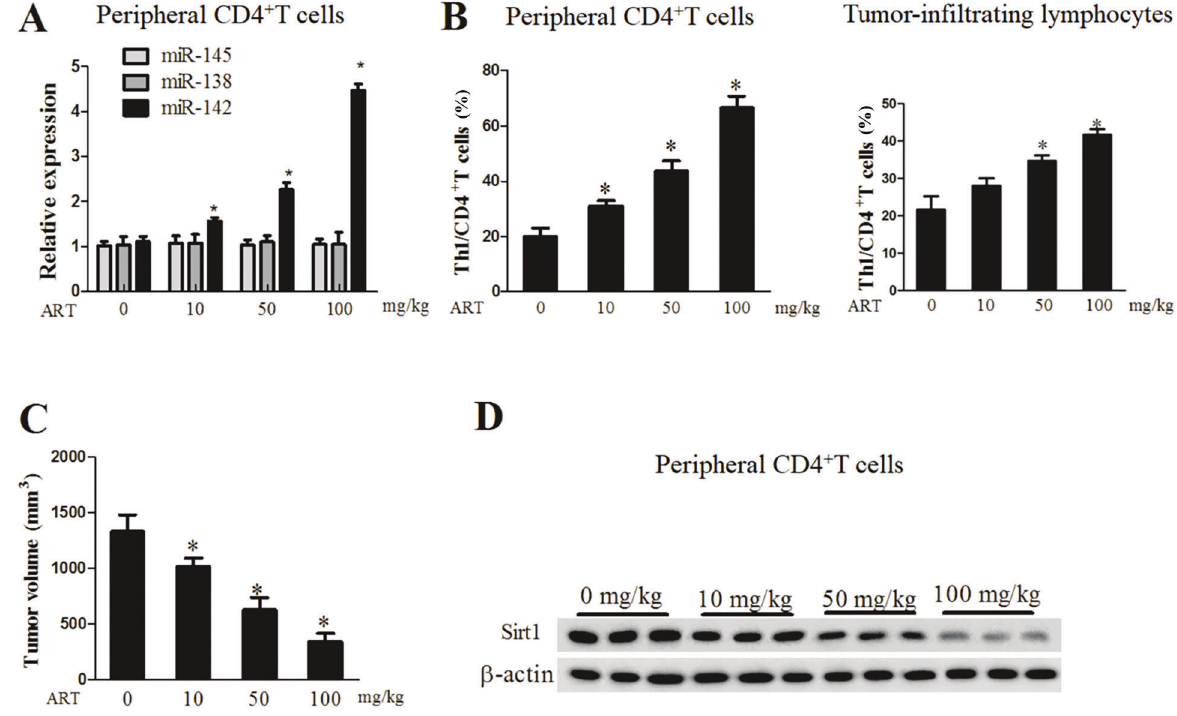
Figure 1. Artesunate (ART) promoted Th1 differentiation and miR-142 expression. A , Expression of miRNAs was quanti fi ed by qRT- PCR. B , Percentage of Th1/CD4 + Tcells in the peripheral CD4 + Tcells and in the tumor-in fi ltrating lymphocytes was analyzed with fl ow cytometry. C , Tumor tissue of mice was excised for volume measurement. D , Sirt1 protein level was determined with western blot. Data are reported as means ± SD. *P o 0.05 compared to 0% ART